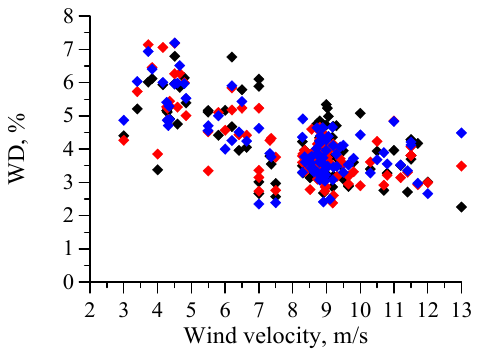
Figure 10. Ratio of subsurface current velocity to wind velocity (data from Figure 4). Black symbols—S-band, red—C-band, blue—X-band.